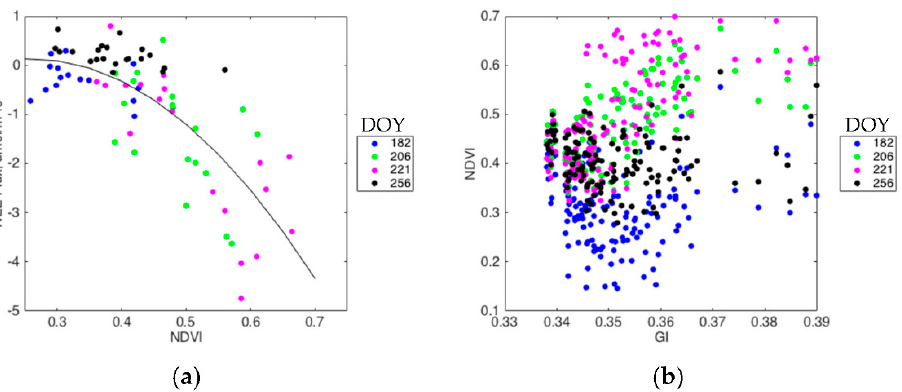
Figure 6. Correlations between ( a ) NDVI and NEEday based the chamber flux measurements on DOY 182, 206, 221 and 256, and ( b ) NDVI and gI (measured on 7 August 2013). In ( b ), NDVI was measured on different dates, while gI values are from the one-time data acquisition.